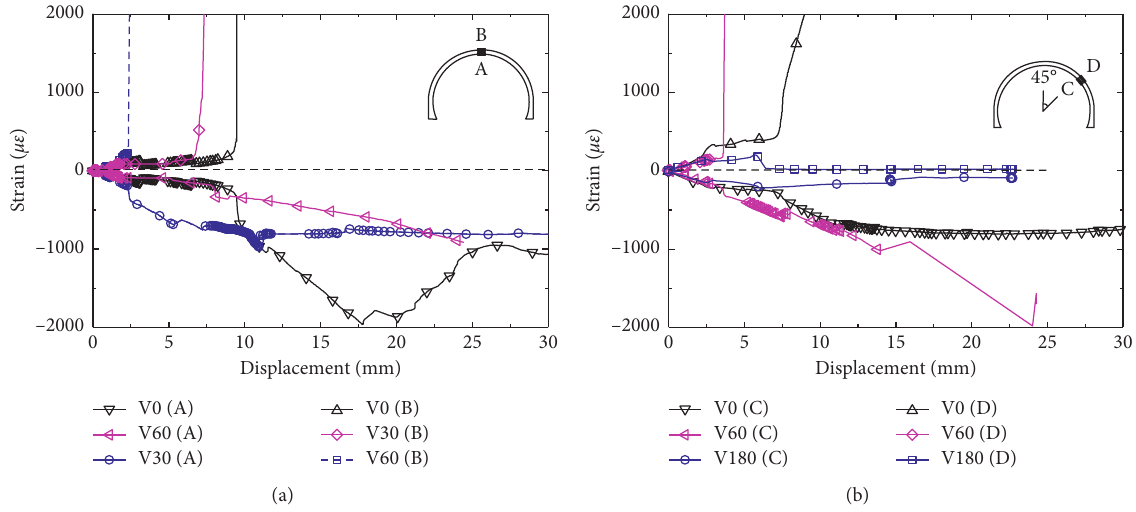
Figure 10: Strain-displacement curve of the lining with void: (a) crown and (b)